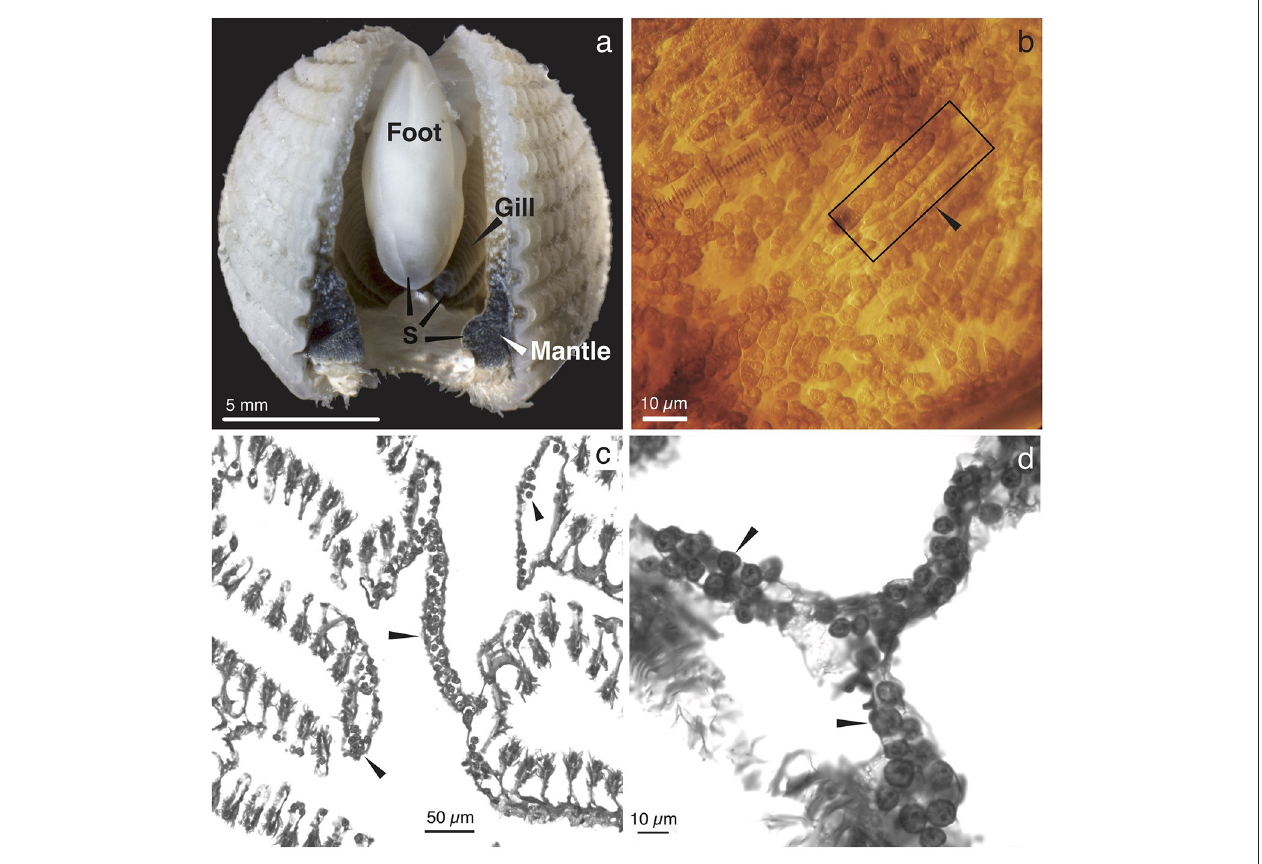
FIGURE 1 | Gross morphology and histology of Fragum scruposum and symbionts. (a) . General morphology of the ventral side of an individual. Dark colored regions were occupied by symbiotic algae (S). (b) . Image of a piece of bivalve mantle tissue. Box highlights tubules that contain symbionts in hospite . Note that the symbiont cells are tightly packed in the tubules. (c) . Light micrograph of a paraffin-embedded cross section through the gill tissue, showing symbionts in tubular network (arrows). (d) . Higher magnifications of symbionts within tubules.